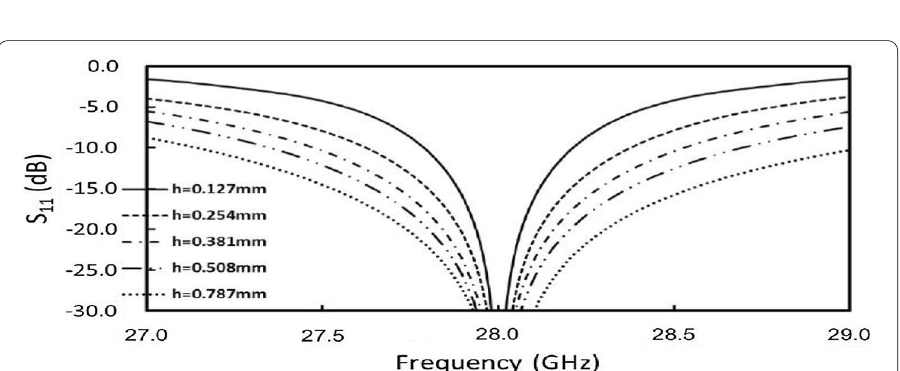
Fig. 6 Simulated antenna S11 versus frequency at different substrate